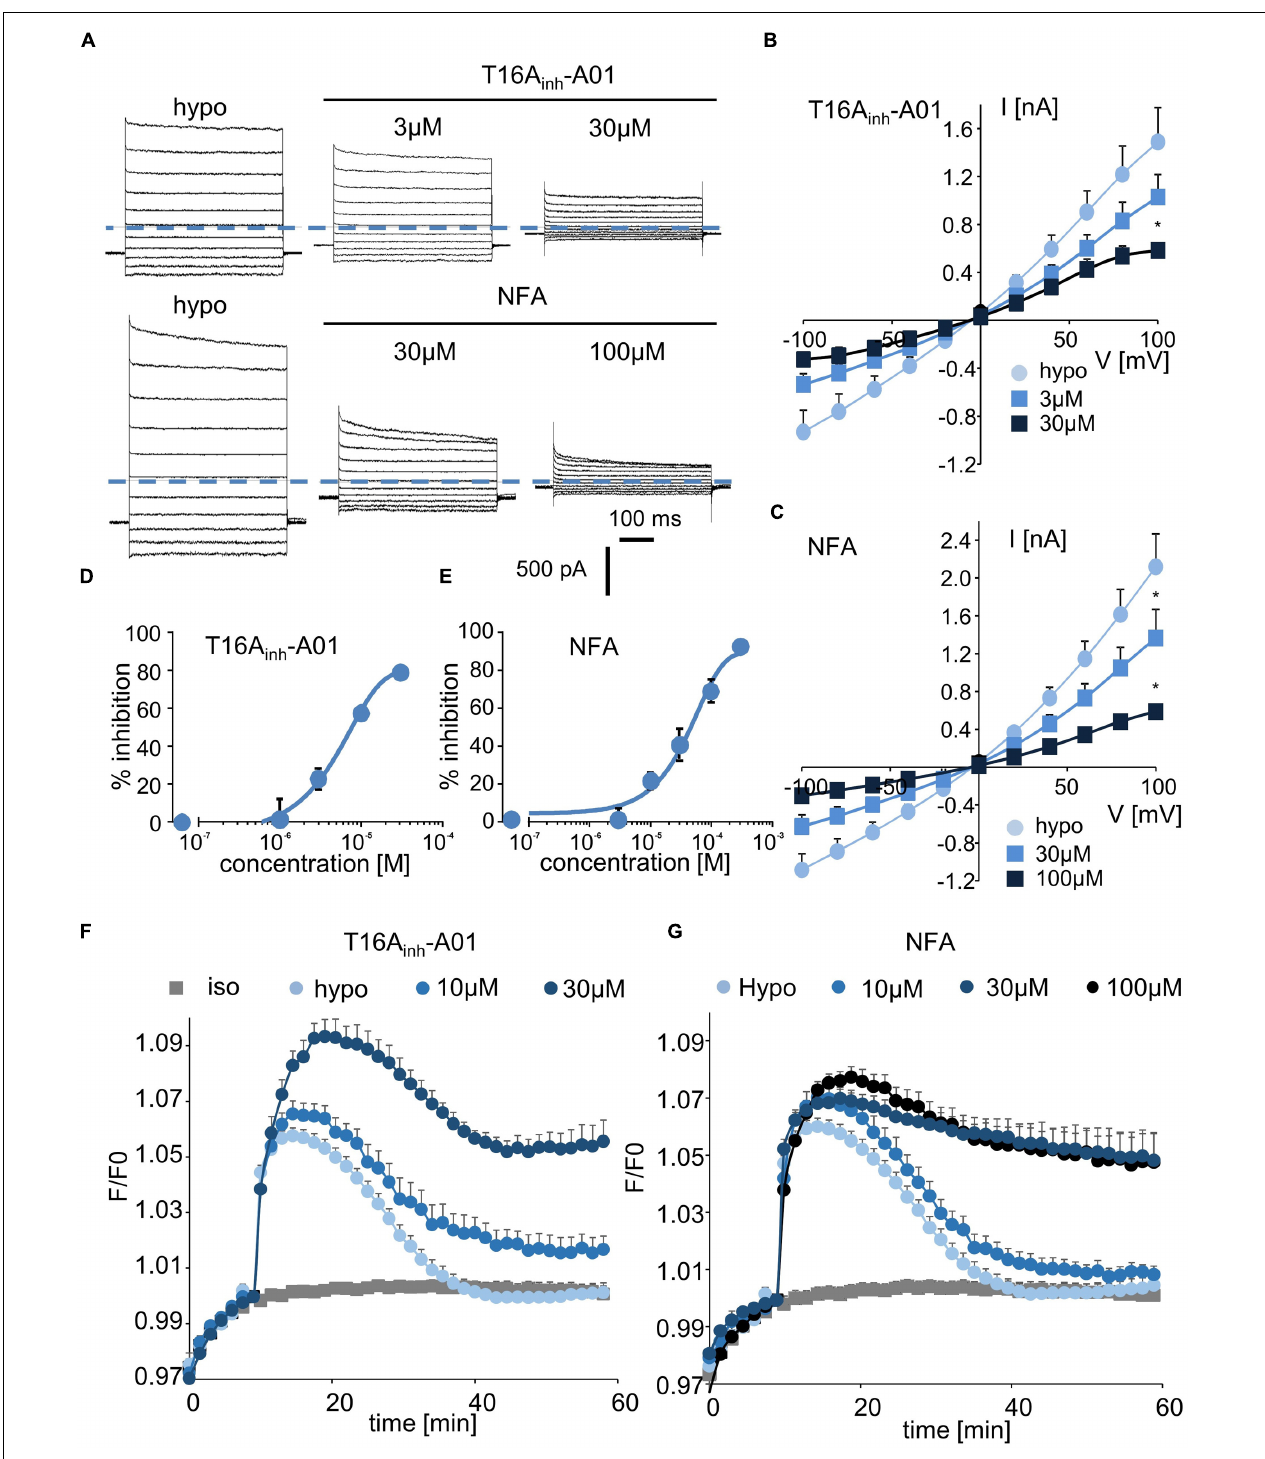
FIGURE 5 | Inhibition of I Cl , swell and RVD by CaCC inhibitors. (A,C) Whole-cell I Cl , swell inhibition by T16A inh -A01 at 3 and 30 µ M and by NFA at 30 and 100 µ M (A) and the relative IV curves (B,C) . (D,E) Inhibition concentration curves permitting IC 50 calculation for T16A inh -A01 and NFA. The reported values are the mean ± SEM of 5 individual records obtained for each experimental concentration and each inhibitor. (F,G) Inhibition by T16A inh -A01 (10 µ M, n = 4; 30 µ M, n = 8) and NFA (10 µ M, n = 4; 30 µ M, n = 12; 100 µ M, n = 8) of RVD following 100 mOsm.l − 1 hypotonic challenge based on calcein relative fluorescence.